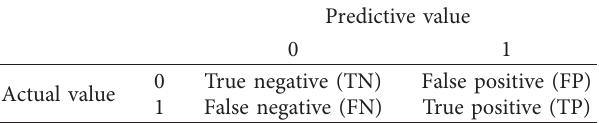
Table 5: Confusion matrix.